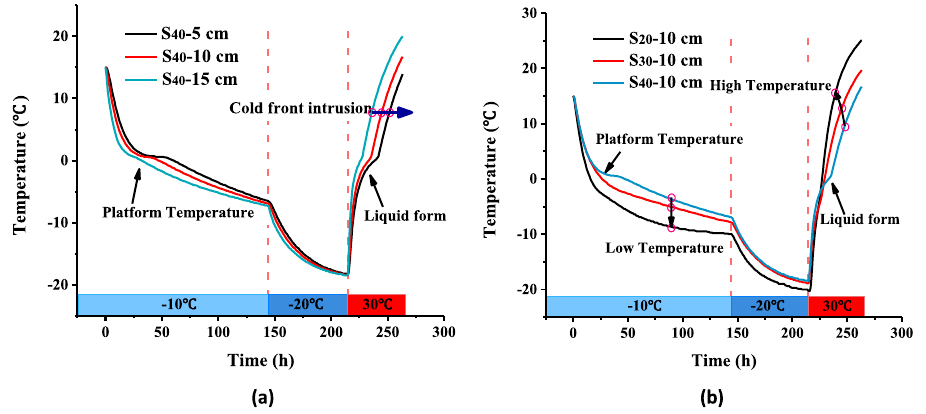
Figure 12. Temperature variation during a single freeze–thaw cycle at ( a ) different depths in the S 40 slope and in ( b ) three slopes at a depth of 10